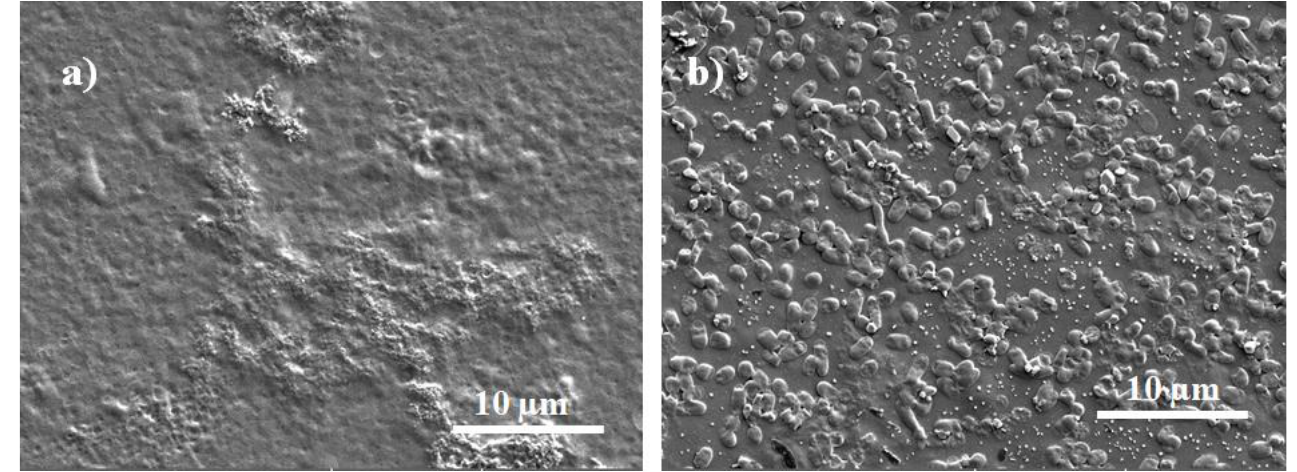
Figure 8. SEM images of the clean PNaSS@PEDOT microsphere film at potential 0.5 V vs. Ag/AgCl reference electrode ( a ) and with bacteria E. coli attached to the surface of the oxidized PNaSS@PEDOT microsphere film ( b ).